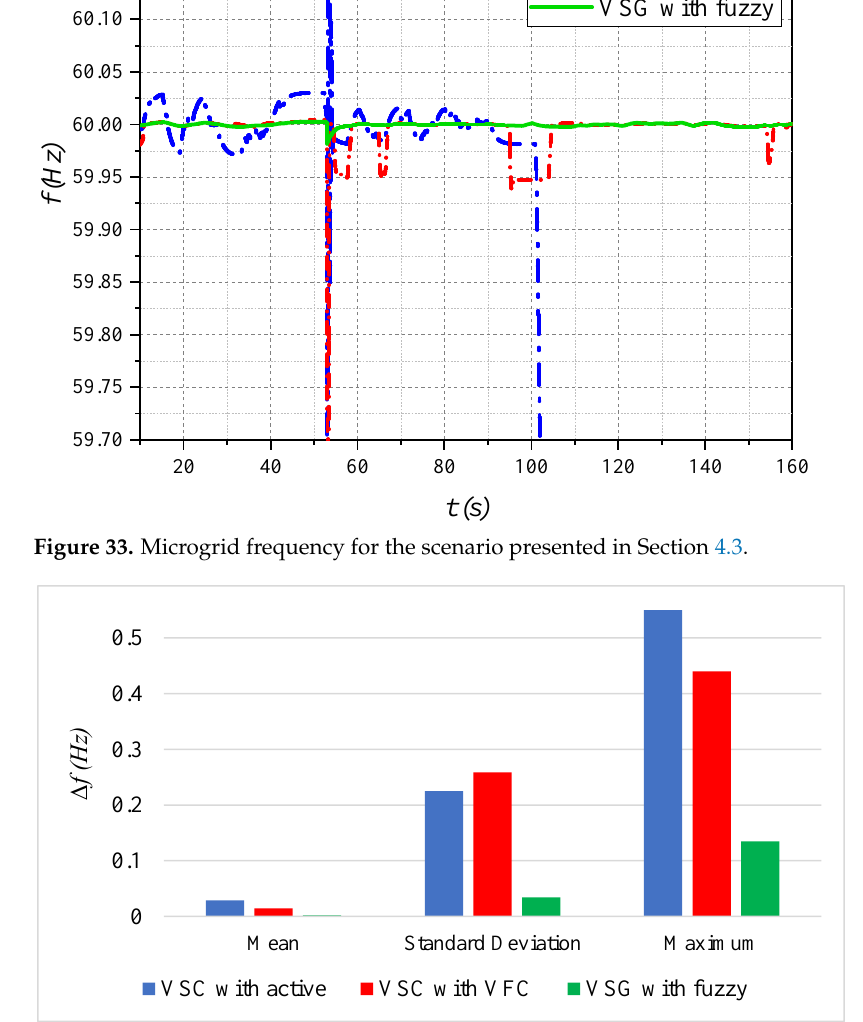
Figure 34. Microgrid frequency statistics for the scenario presented in Section